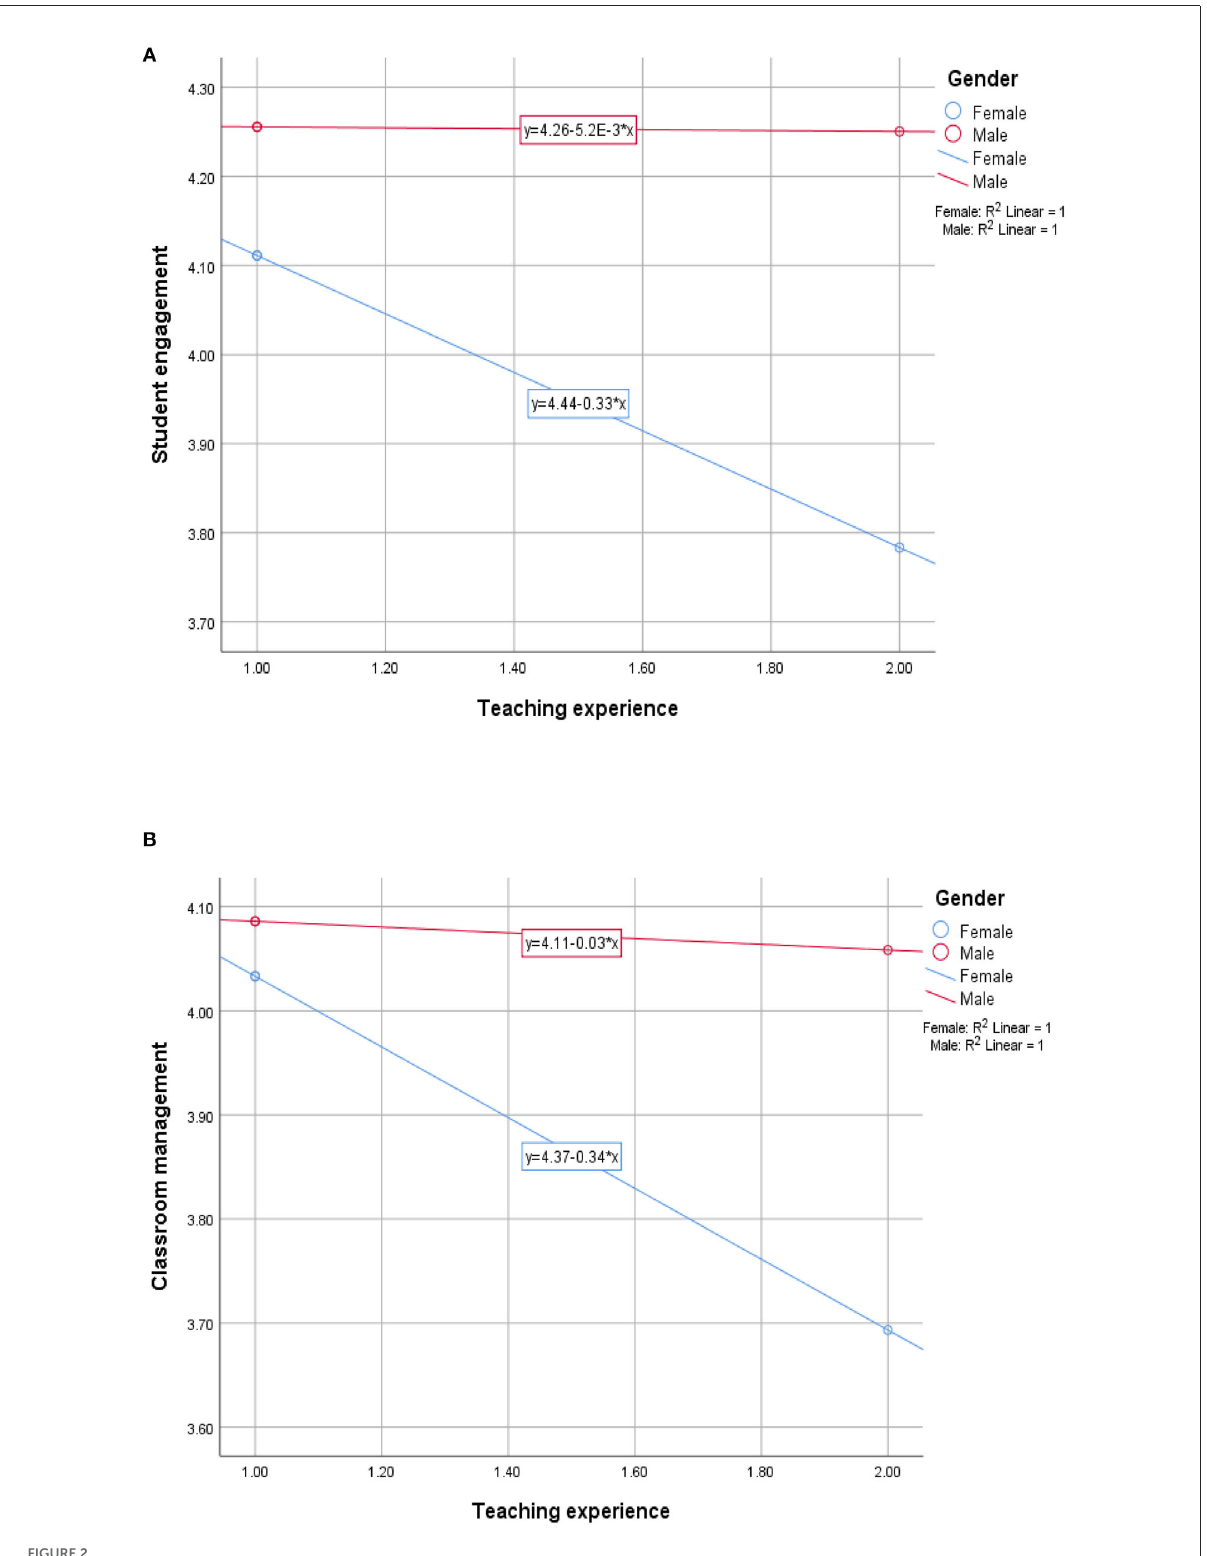
FIGURE2 (A) Moderation effect of gender in the relationship between teaching experience and self-efficacy beliefs in student engagement. (B) Moderation effect of gender in the relationship between teaching experience and self-efficacy beliefs in classroom